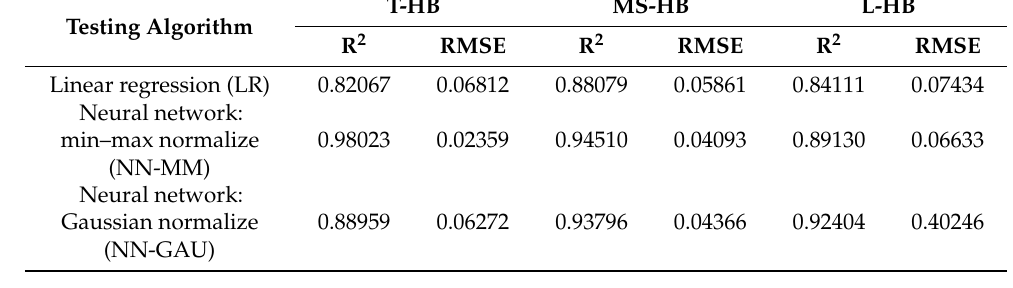
Table 4. Performance values of predicted test data.